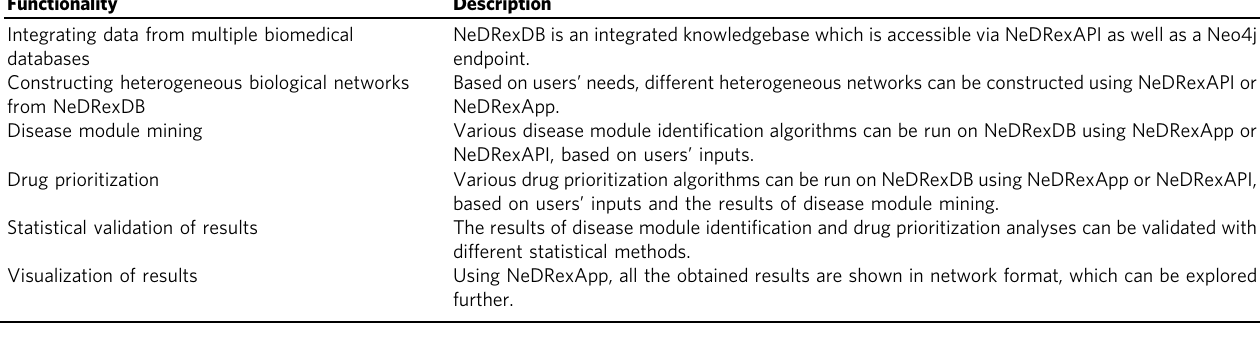
Table 1 Overview of the main functionalities of the NeDRex platform. Functionality Description Integrating data from multiple biomedical